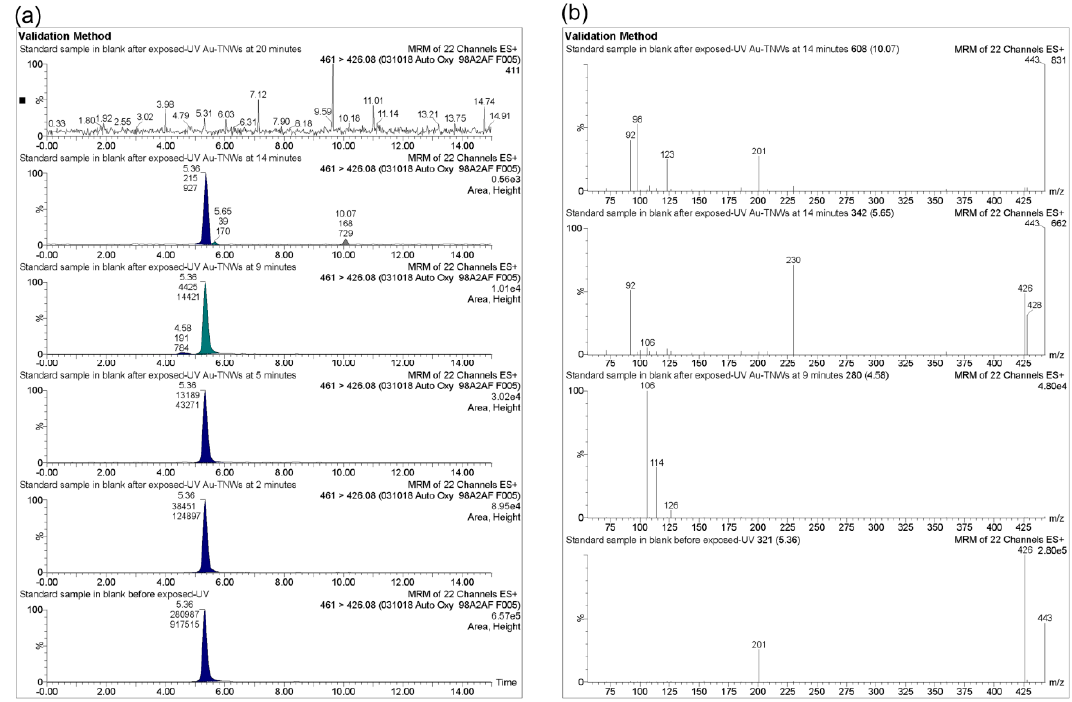
Figure 6. ( a ) Chromatogram ultra performance liquid chromatography (UPLC)-MS / MS photocatalytic degradation kinetic model of oxytetracycline (OTC, 500 ng / mL) with exposure to UV-VIS and Au-TNWs /